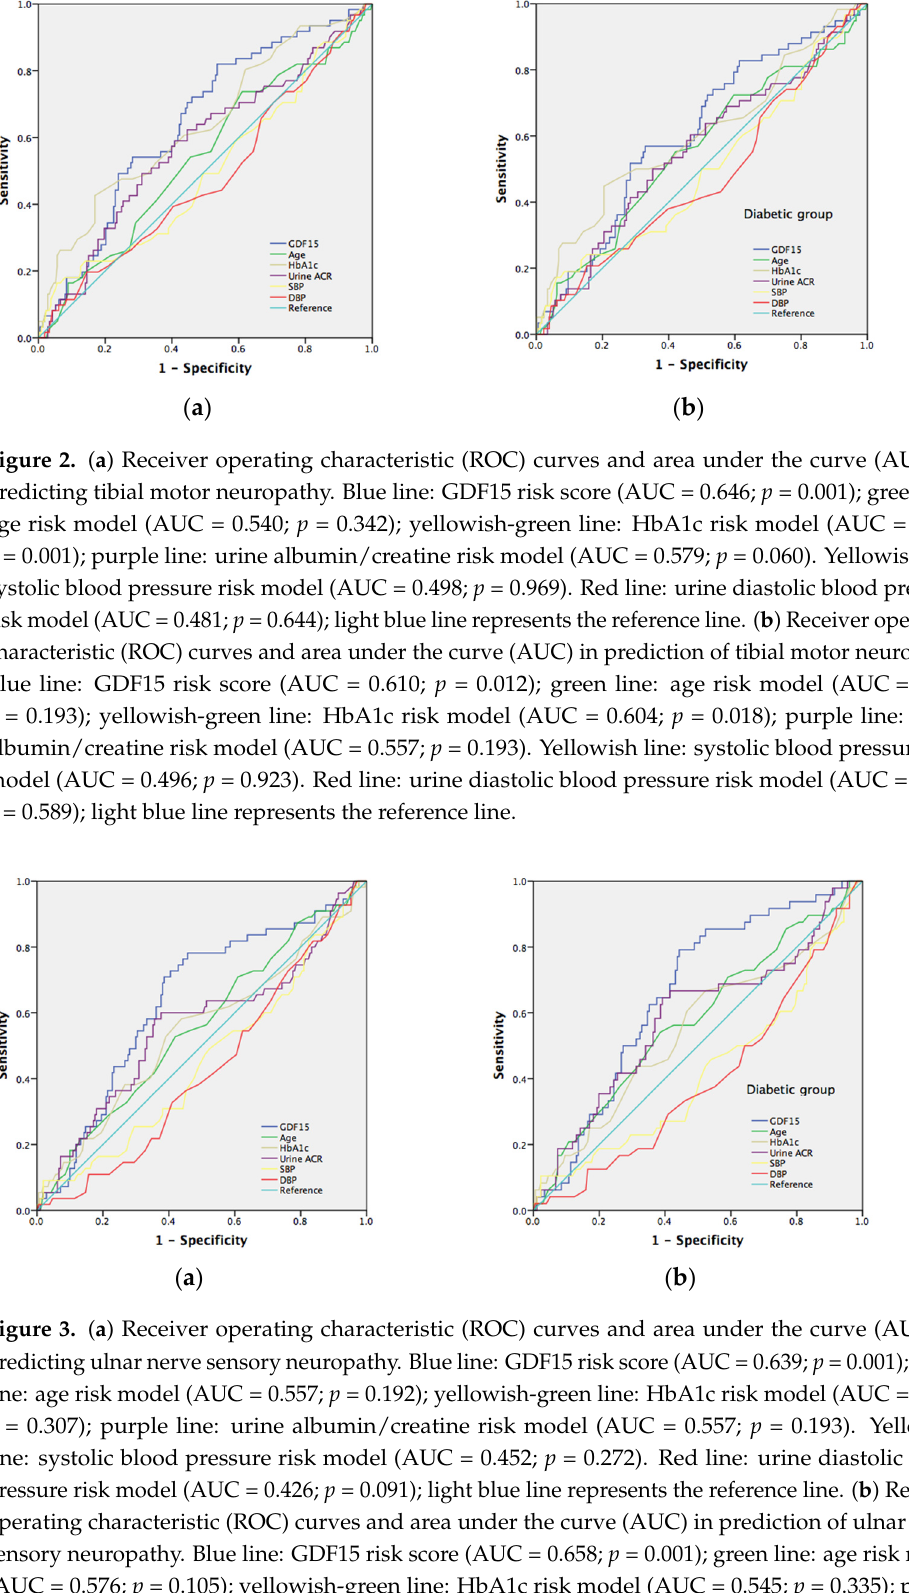
Figure 4. ( a ) . Receiver operating characteristic (ROC) curves and area under the curve (AUC) in prediction of median nerve sensory neuropathy. Blue line: GDF15 risk score (AUC = 0.633; p = 0.007); green line: age risk model (AUC = 0.587; p = 0.078); yellowish-green line: HbA1c risk model (AUC = 0.631; p = 0.008); purple line: urine albumin/creatine risk model (AUC = 0.546; p = 0.354). Yellowish line: systolic blood pressure risk model (AUC = 0.577; p = 0.117). The red line: urine diastolic blood pressure risk model (AUC = 0.497; p = 0.957); light blue line represents the reference line. ( b ) Receiver operating characteristic (ROC) curves and area under the curve (AUC) in predicting median nerve sensory neuropathy. Blue line: GDF15 risk score (AUC = 0.611; p = 0.032); green line: age risk model (AUC = 0.609; p = 0.035); yellowish-green line: HbA1c risk model (AUC = 0.607; p = 0.038); purple line: urine albumin/creatine risk model (AUC = 0.532; p = 0.538). Yellowish line: systolic blood pressure risk model (AUC = 0.559; p = 0.250). Red line: urine diastolic blood pressure risk model (AUC = 0.479; p = 0.687); light blue line represents the reference line.